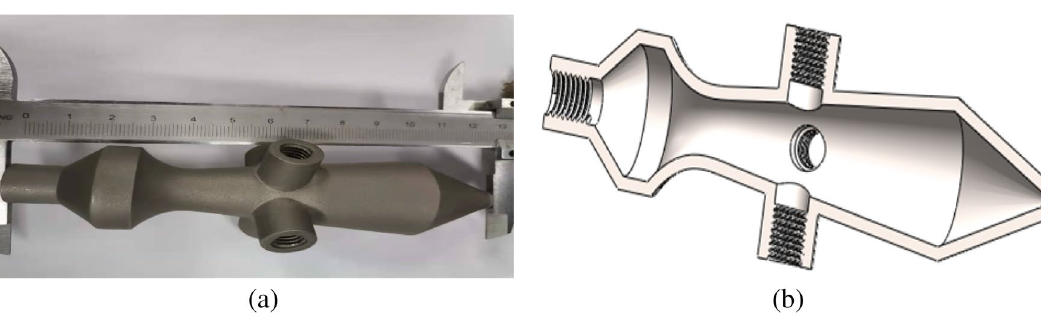
Figure 5. Working atomizing nozzle model. ( a ) Nozzle physical object. ( b ) Internal cross section of